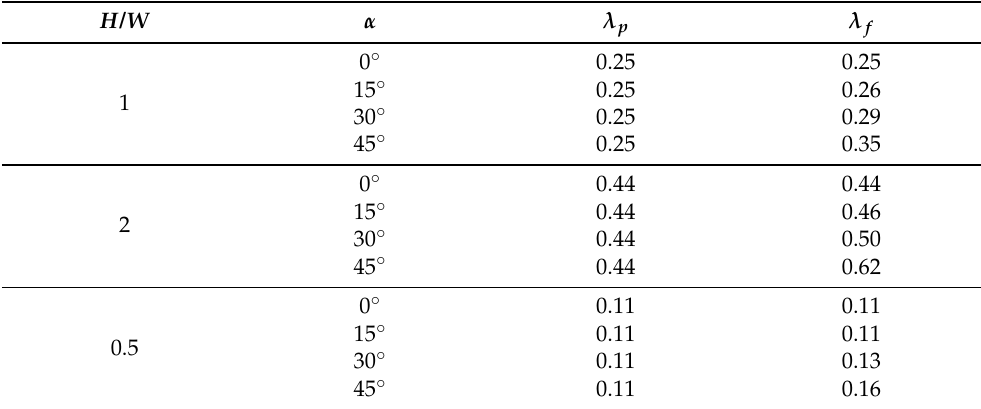
Table 3. Urban morphology